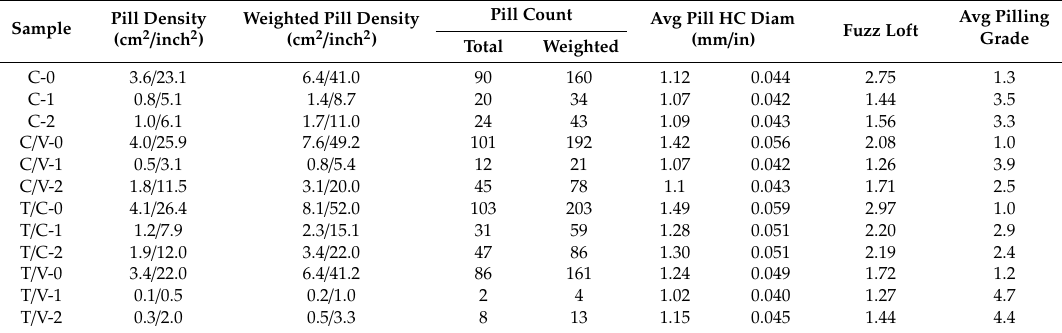
Figure 5. Pilling grade ( a ), pill size and volume distribution ( b ) of original and treated fabrics after 2000 rubs. Table 2. Pill density, pill count, average pill height-compensated diameter (avg pill HC diam), fuzz loft and average pilling grade of original and treated fabrics after 2000 rubs.